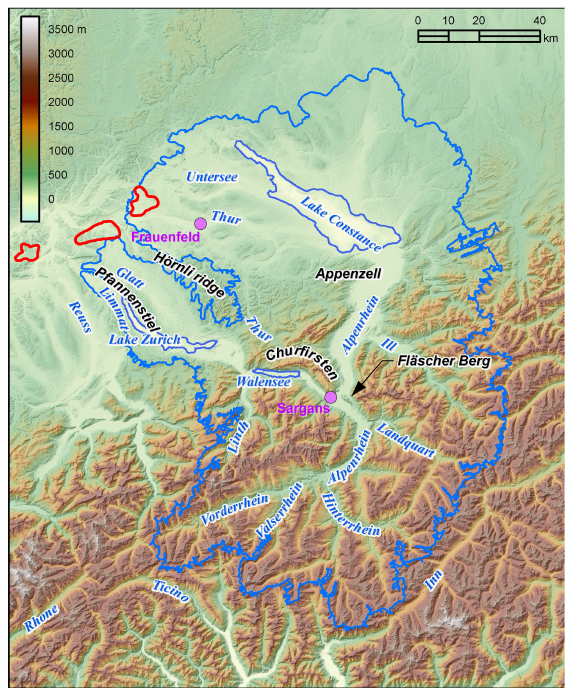
Figure 3. Basal topography (from Benz-Meier, 2003) used in all simulations with names of major valleys, present-day lakes, cities, and mountains mentioned in text. The blue outline of the Rhine glacier at the LGM is from Benz-Meier (2003). See text for details. The three proposed siting regions for high-level waste repositories in Switzerland are shown in red. All three sites are located within the ice extent of earlier glaciations larger than the